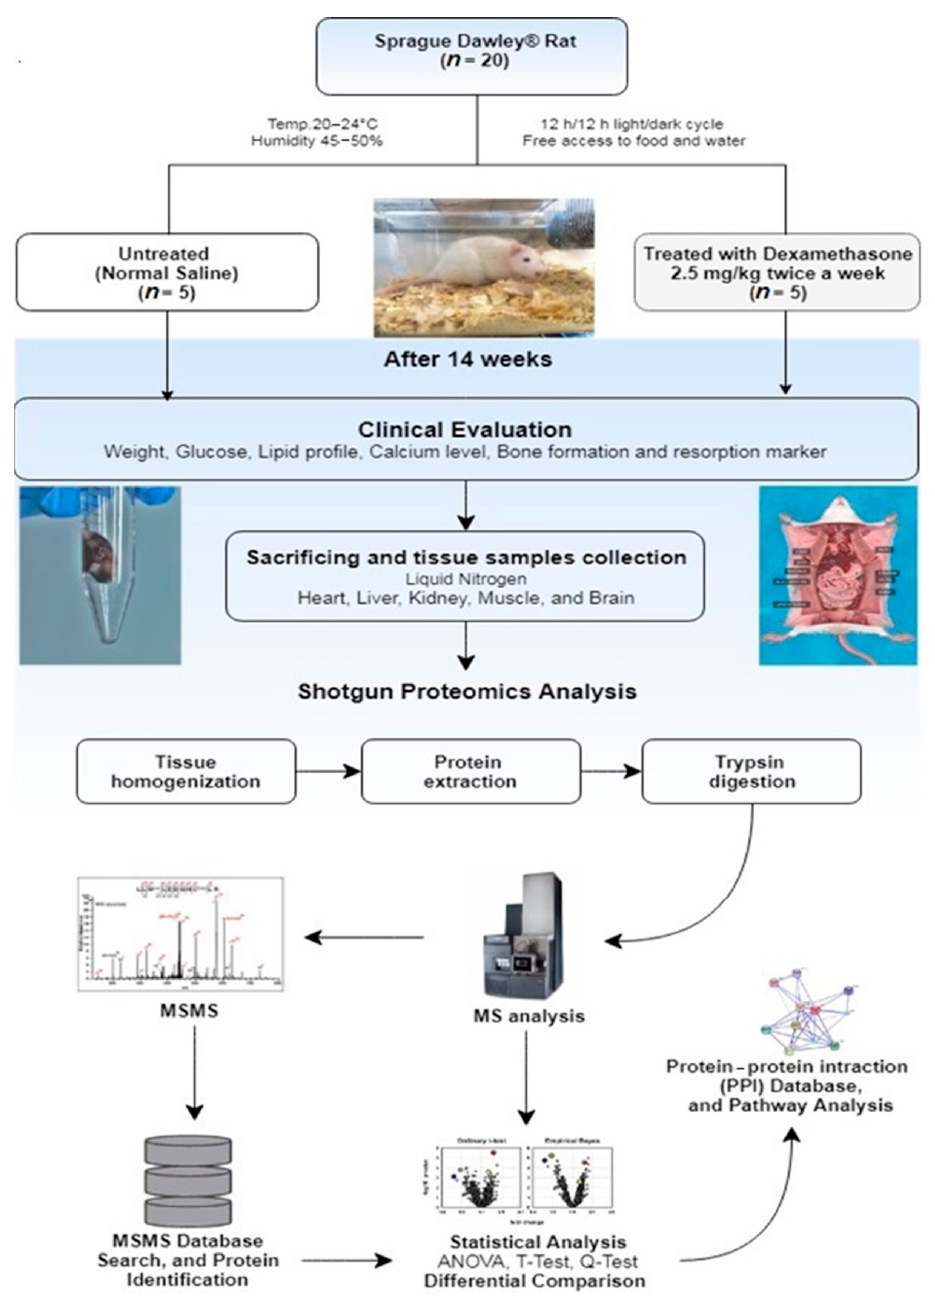
Figure 1. A flow chart of the animal study design and proteomics based liquid chromatography-tandem mass spectrometry (LC-MS / MS) experiment. Sprague–Dawley rats were divided into two groups; control ( n = 10) and Dex ( n = 10). After 14 weeks of twice-weekly treatment with Dex, the proteomics profile of freshly collected tissue samples from major body organs were studied using shotgun proteomics analysis.